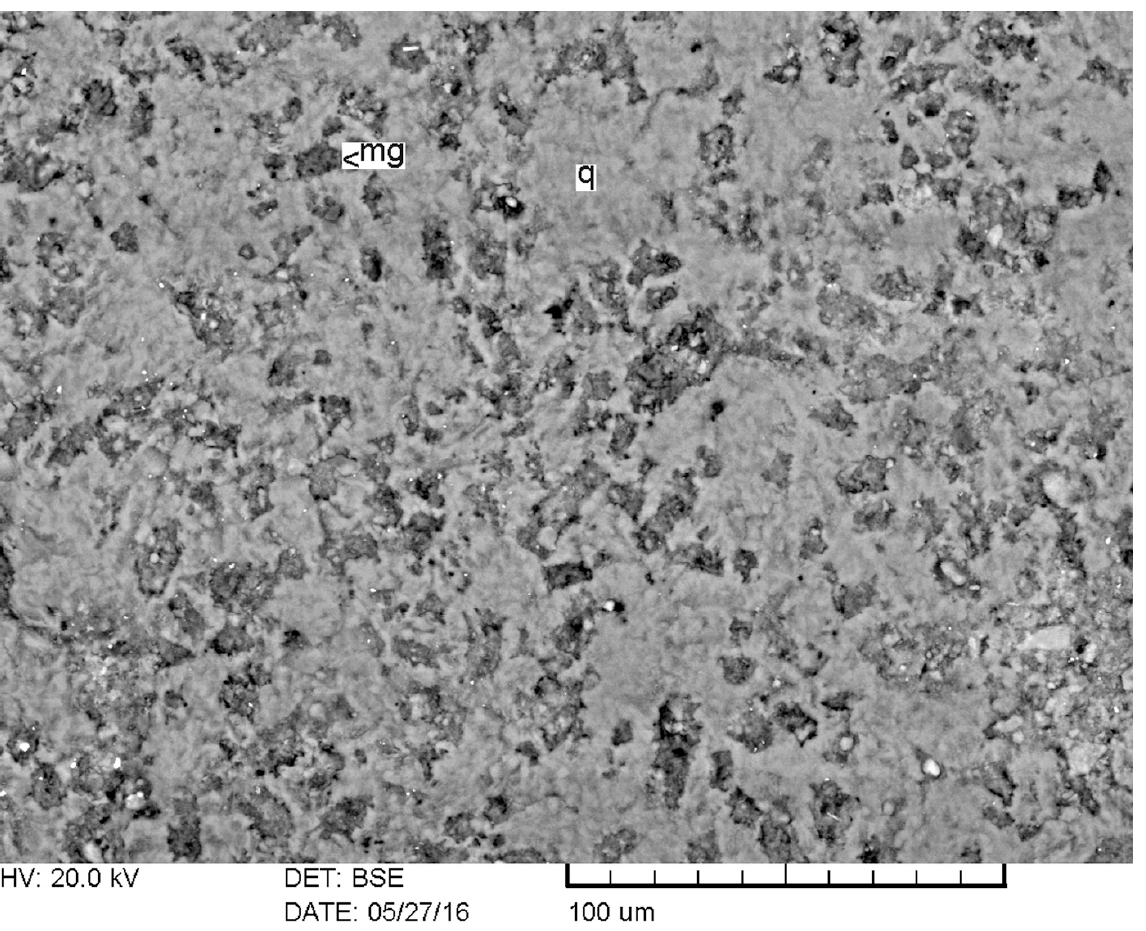
Figure 7. BSE image of Neolithic white stone polished tool (GOR-293, Gorzsa tell): q for quartz, Mg for